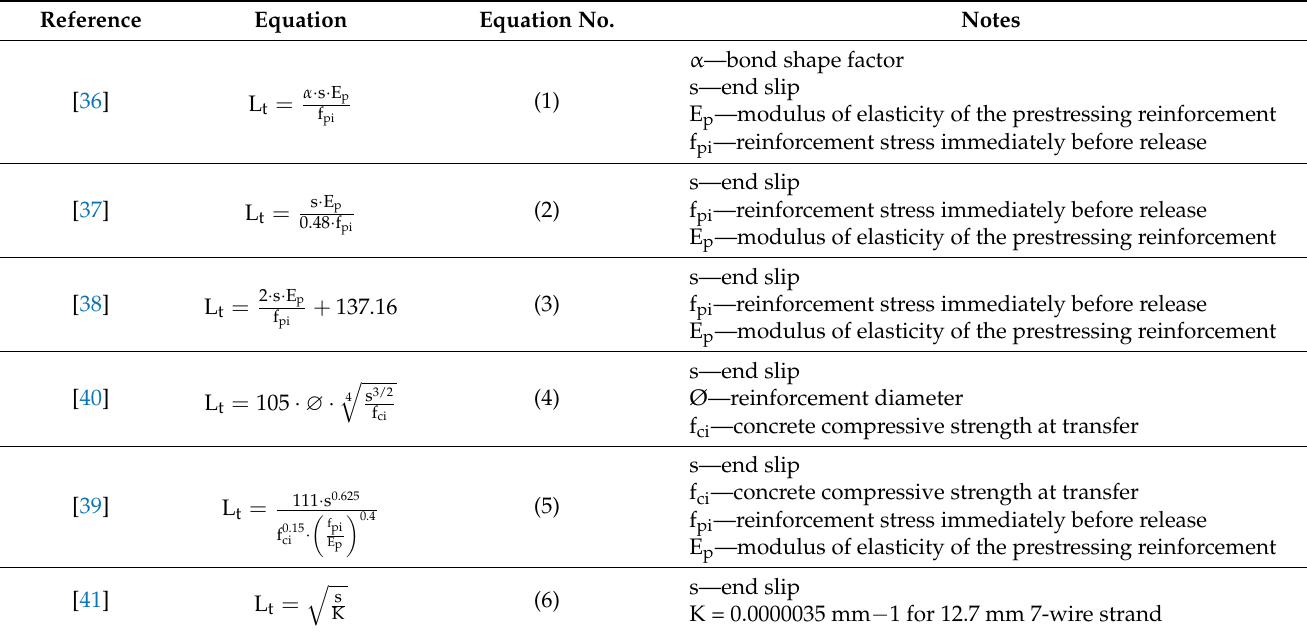
Table 1. Summary of the relationships between transfer length and slip of steel strands. Reference Equation Equation